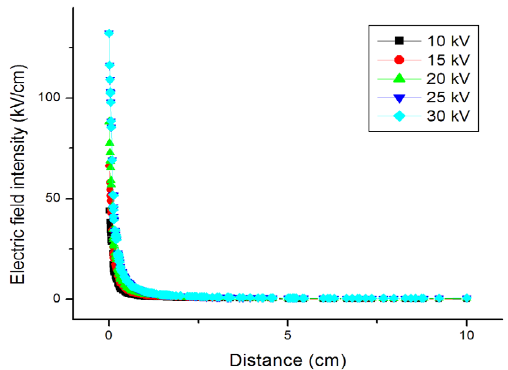
Fig. 2. The intensity of electric field along the spinning direc- tion at different applied voltage.